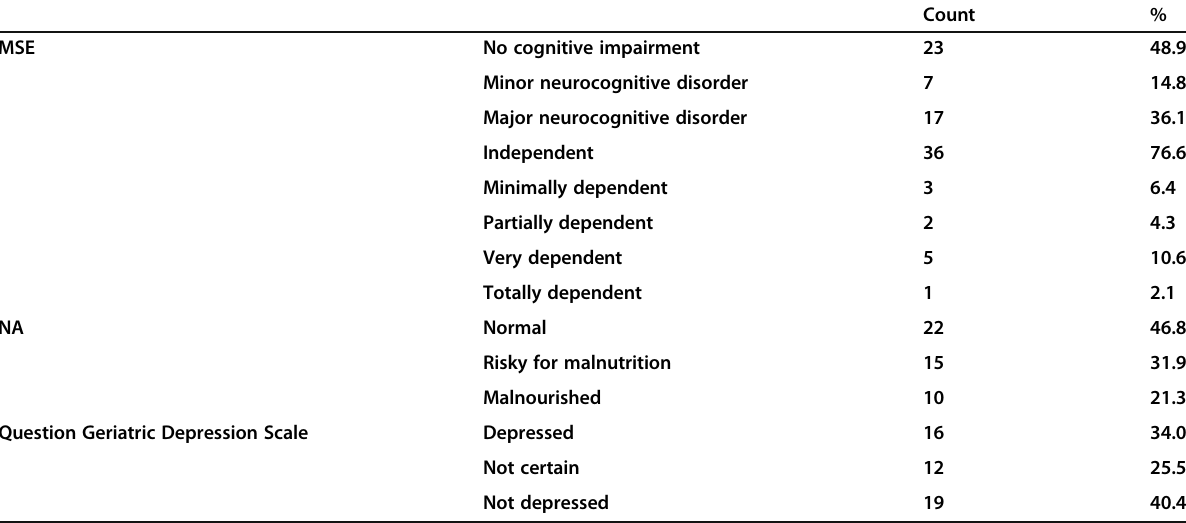
Table 3 Description of geriatric assessment